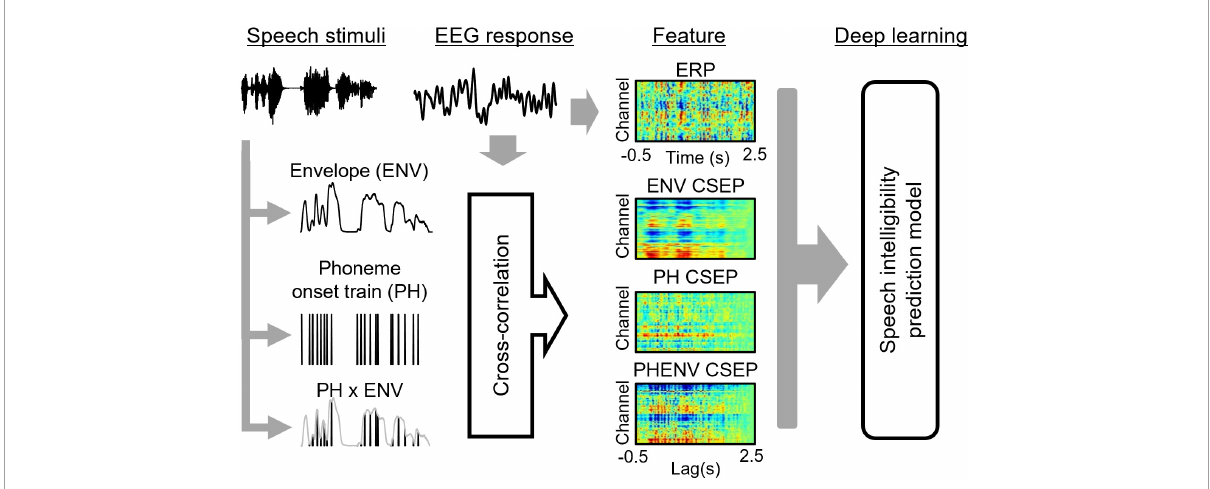
FIGURE3 The overall scheme of speech intelligibility prediction, including speech stimuli, electroencephalogram data, feature extraction, and model prediction. The speech features of envelope (ENV), phoneme onset train (PH), and ENV ⊗ PH generate the features of ENV continuous-speech evoked potentials (CSEP), PH CSEP, and PHENV CSEP by cross-correlating with the electroencephalogram response (EEG).